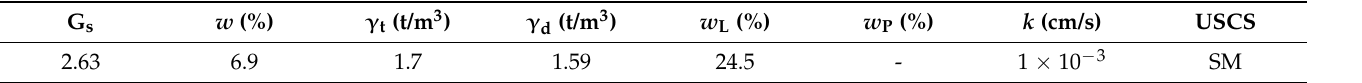
Table 1. Physical properties of landslide materials